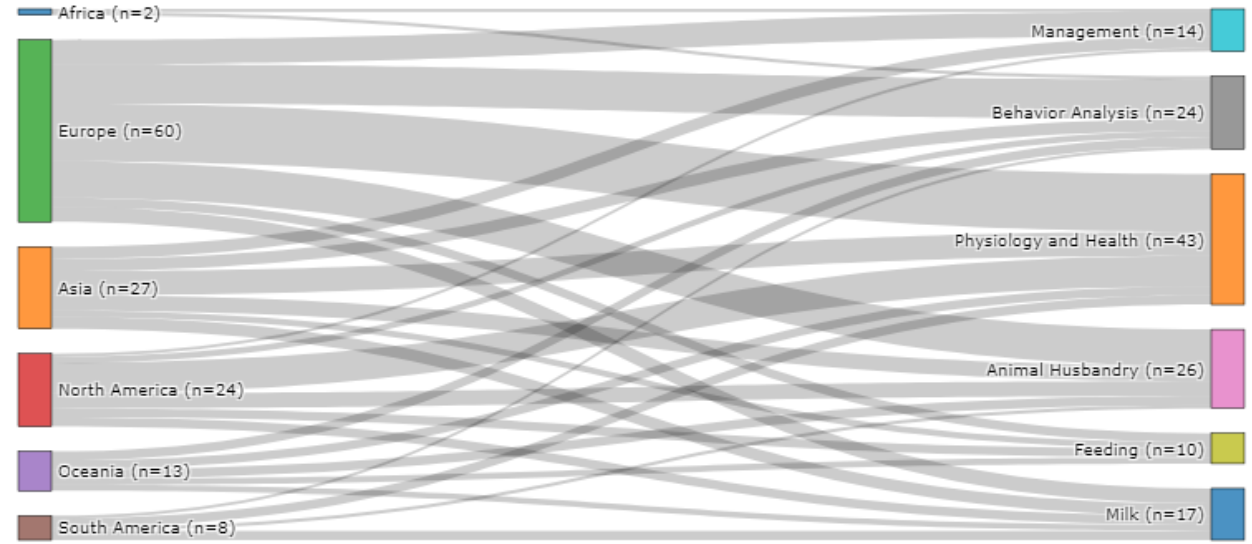
Figure 3. The flow of studies from geographical location to research categories (n =